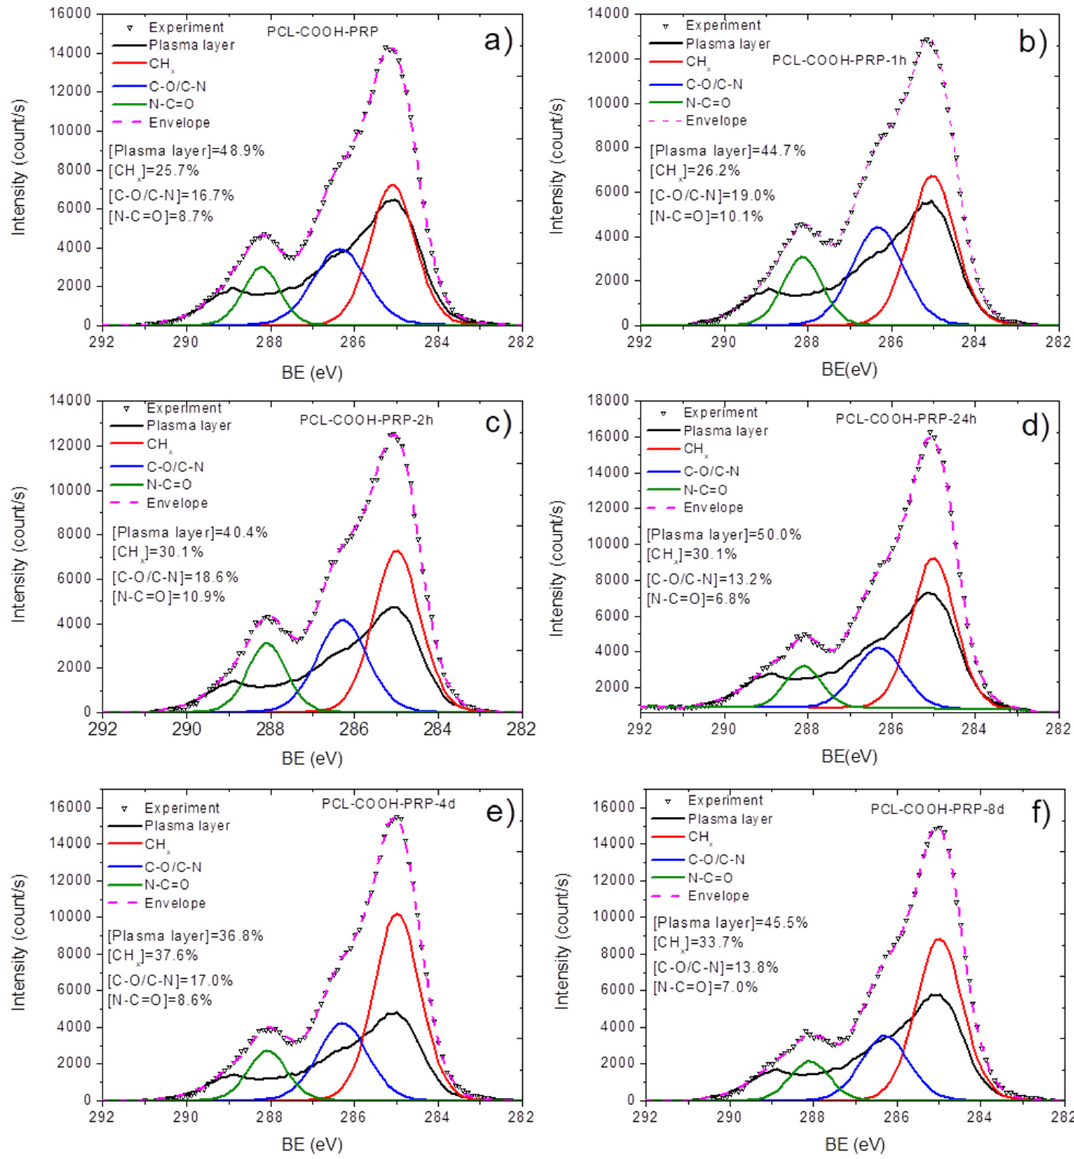
Figure 3. XPS C1s curve fitting of plasma-modified nanofibers with immobilized PRP as prepared PCL-COOH-PRP ( a ), after soaking in water at pH = 7 during 1 h PCL-COOH-PRP-1h-pH7 ( b ), after soaking in water at pH = 7 during 2 h PCL-COOH-PRP-2h-pH7 ( c ), after soaking in water at pH = 7 during 1 day PCL-COOH-PRP-1d-pH7 ( d ), after soaking in water at pH = 7 during 4 days PCL-COOH-PRP-4d-pH7 ( e ), after soaking in water at pH = 7 during 8 days PCL-COOH-PRP-8d-pH7 ( f ).